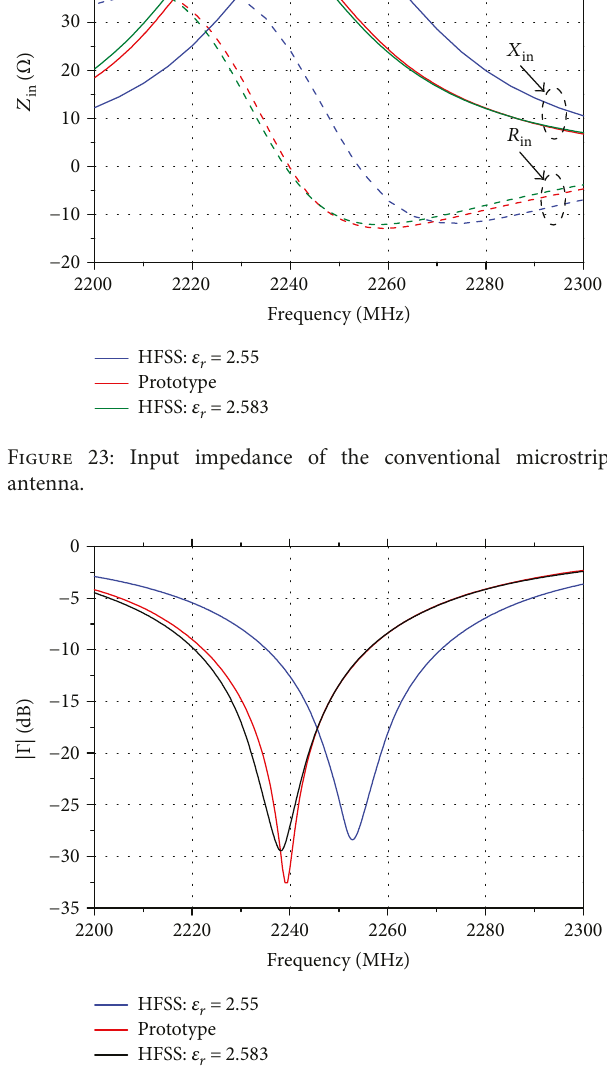
Figure 24: Re fl ection coe ffi cient module of the conventional microstrip antenna.